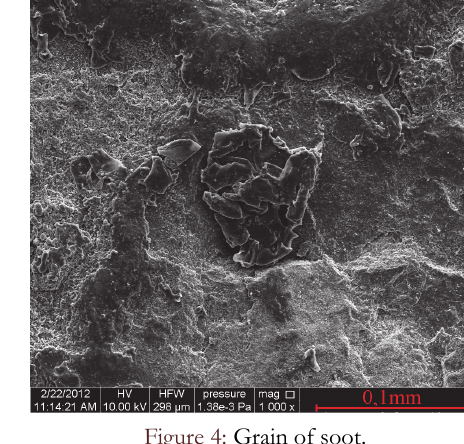
Figure 3: Chemical elements. Figure 4: Grain of